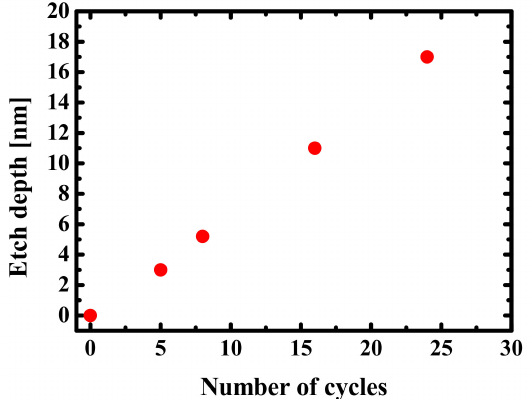
Figure 5. Etch depth versus number of etching